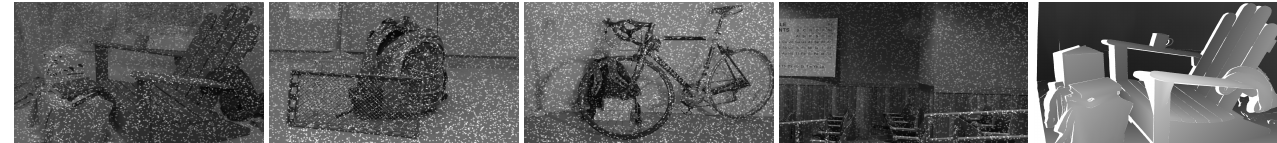
Figure 2. Some sets of left images with synthetically projected pattern. The last image is the GT disparity map of the first image.